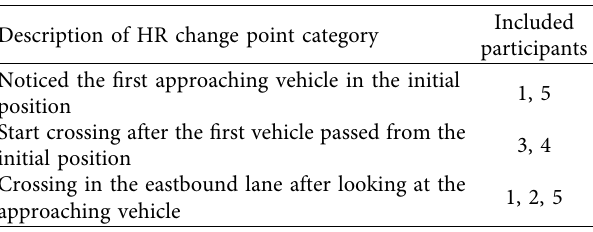
Figure 7: Pedestrian’s HR change point analysis over time with other physiological responses. (a) Video snapshot of HR change point event 1. The pedestrian noticed the first approaching vehicle. (b) Visualizations of different physiological data. I: HR (blue) and HR BCP probability (red); II: horizontal head movement direction (black) and horizontal gaze direction (green); III: stationary gaze entropy (SGE) (cyan) and SGE BCP probability (red); IV: gaze transition entropy (GTE) (yellow) and GTE BCP probability (red) (c) Video snapshot of HR change point event 2. The pedestrian is crossing in the eastbound lane, just after looking at the approaching vehicle in the lane. Table 5: Summary of pedestrian HR change